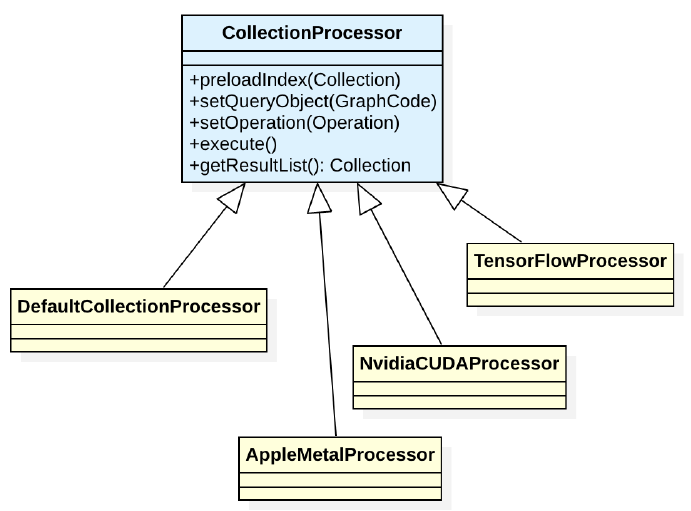
Figure 10. Collection processor structure for the distribution of collections and